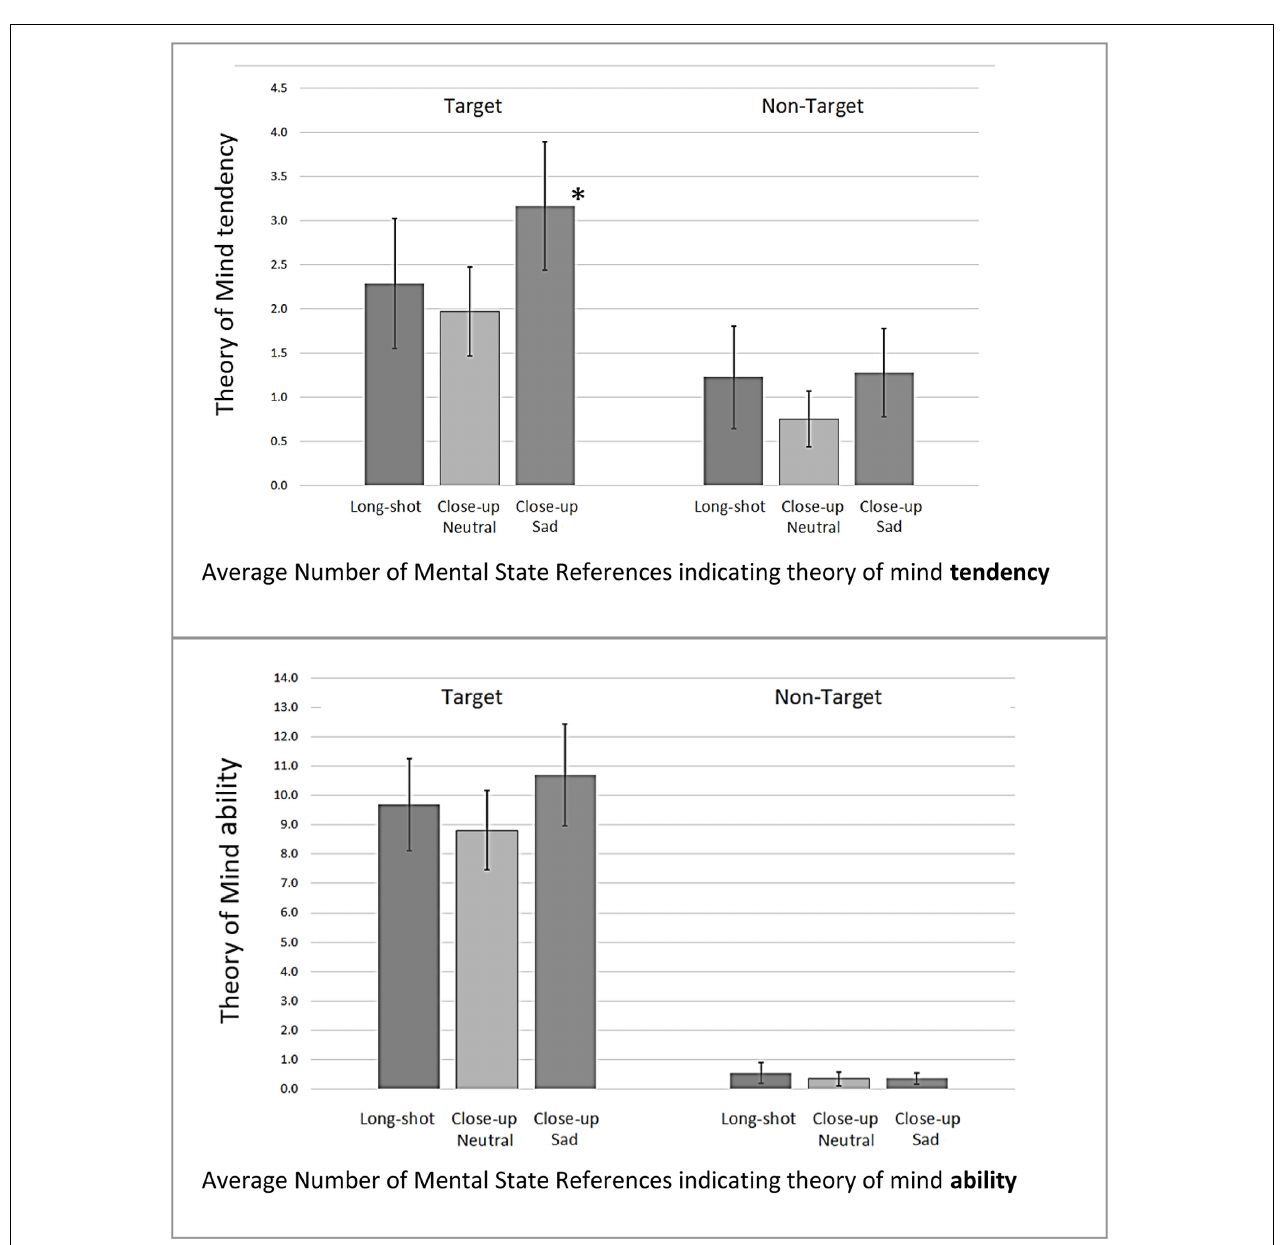
FIGURE 2 | Average number of mental state references indicating theory of mind tendency (top) and ability (bottom) with 95% Confidence Intervals (means shown regardless of word-count). Mental state references are presented categorized by whether they referred to the Target character or Non-target character. The conditions listed on the X -axis indicate the way in which the target character was depicted (non-target character was depicted in long shot for each condition). ∗ ToM-tendency was significantly higher in for the target character when she was presented in close-up with a sad facial